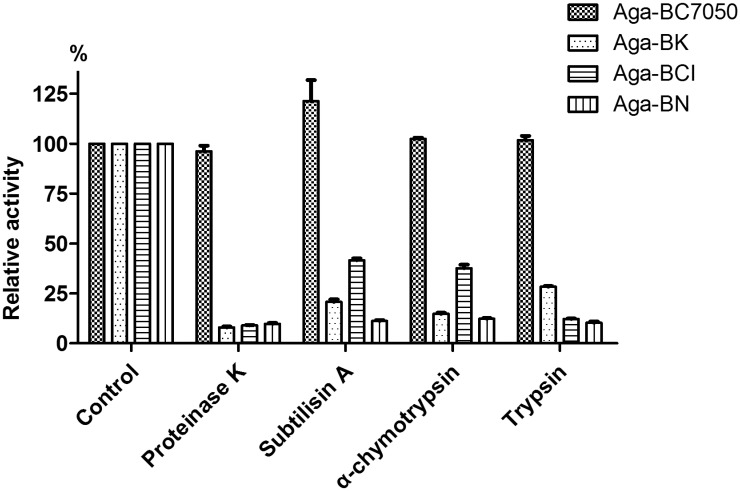
Effect of proteases on the enzyme activity of Aga-BC7050, Aga-BK, Aga-BCI, and Aga-BN.The purified enzymes were pre-incubated with protease at a 1:10 (w/w) ratio in 100 mM Tris-HCl buffer (pH 7.4) at 37 °C for 30 min, and the enzyme activity was then measured under standard conditions. The activity of α-galactosidase without protease was set to 100%. Values represent the mean ± SD (n = 3).